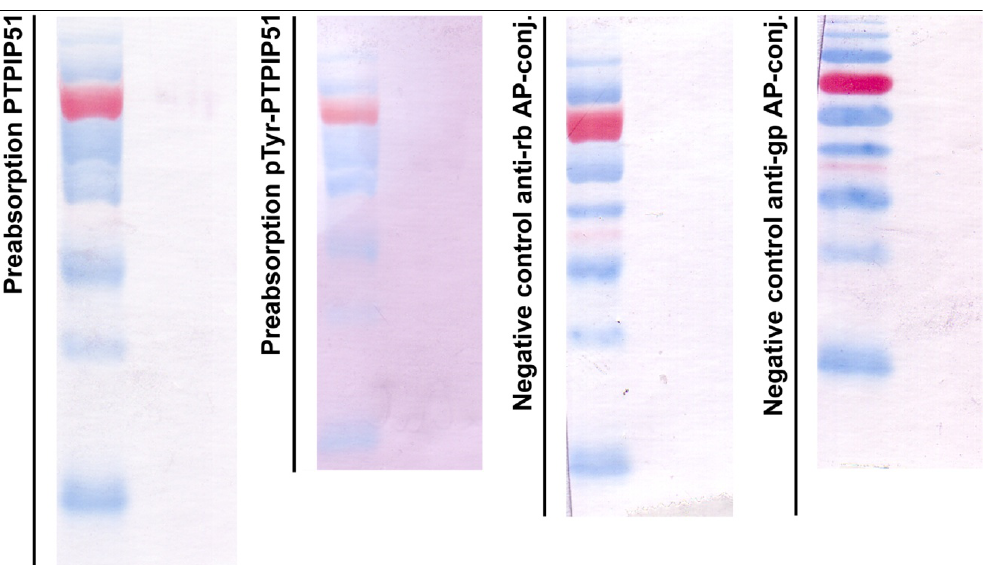
Figure 1. Control experiments for immunoblotting. First panel: immunoblot done with the preabsorbed P51ab-antibody. Second panel: immunoblot done with preabsorbed P51ab-PTyr antibody. Third panel: Negative control with the omission of the P51ab antibody. Fourth panel: Negative control with the omission of the P51ab-PTyr